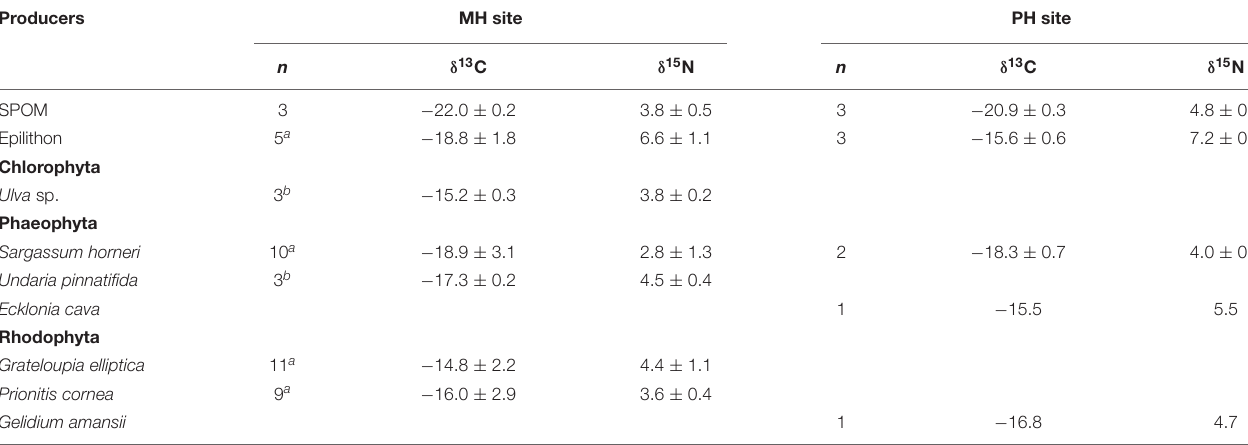
) of primary producers collected at the two sampling sites, MH, and PH. TABLE 1 | δ 13 C and δ 15 N values ( (cid:104)